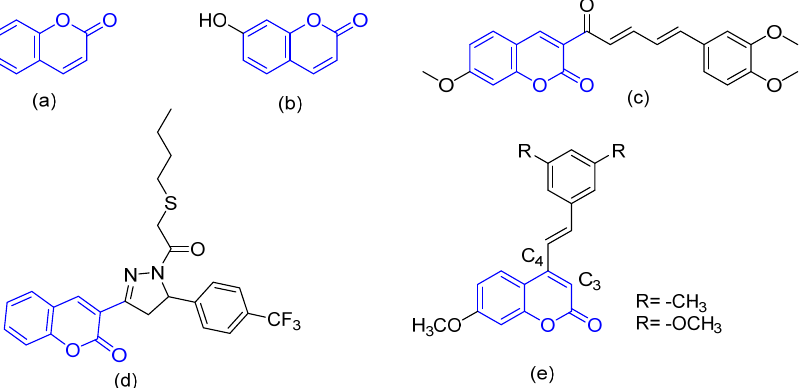
Figure 1. Library of structures with a coumarin core: ( a ) coumarin, ( b ) 7-hydroxycoumarin, ( c ) Siedel’s cytostatic coumarin, ( d ) Wu’s coumarin cytostatic agent, and ( e ) coumarin-stilbene.